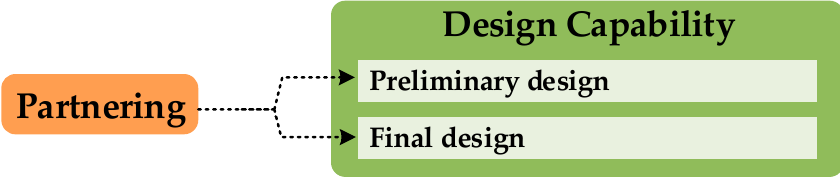
Figure 4. Relationship between partnering and design capability.